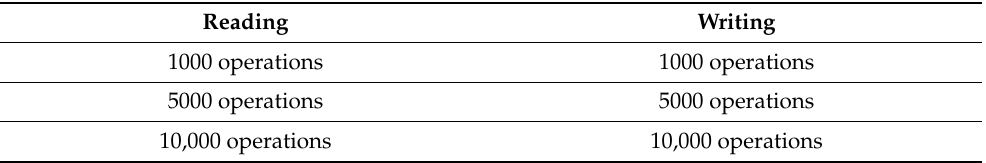
Table 8. Scenarios for the comparison experiment. Reading Writing 1000 operations